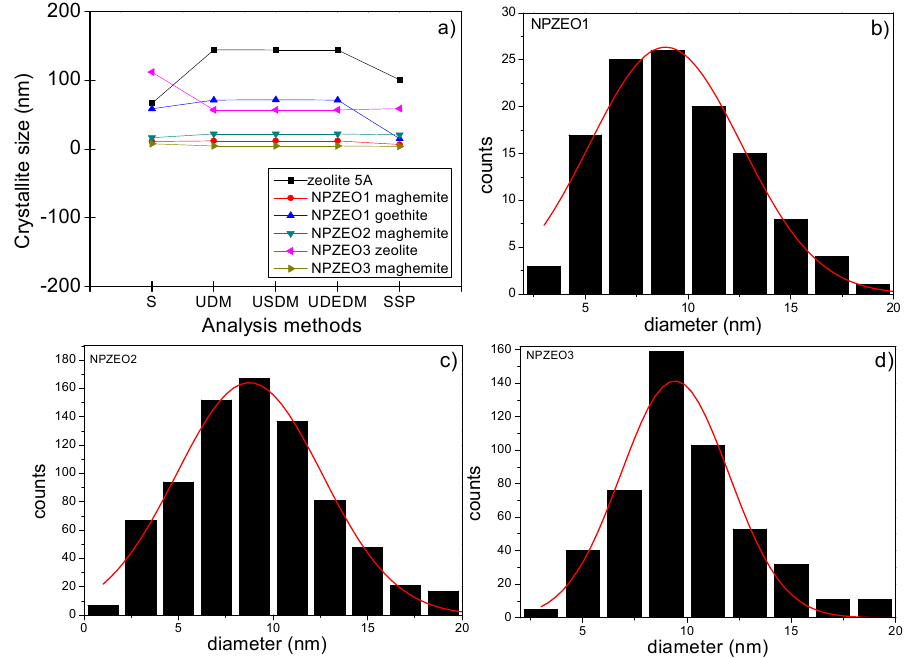
Figure 3. Crystallite size achieved by the analysis methods for all samples ( a ). Particle size distribution for the NPZEO1 ( b ), NPZEO2 ( c ), and NPZEO3 ( d ) samples.